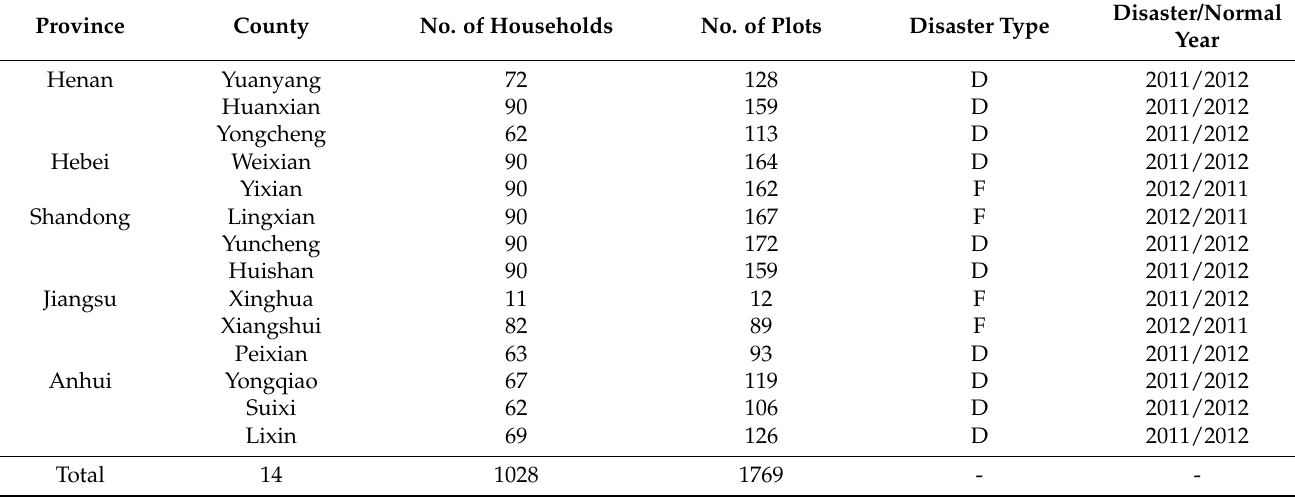
Table 2. The sample distribution of summer maize for the NCP.